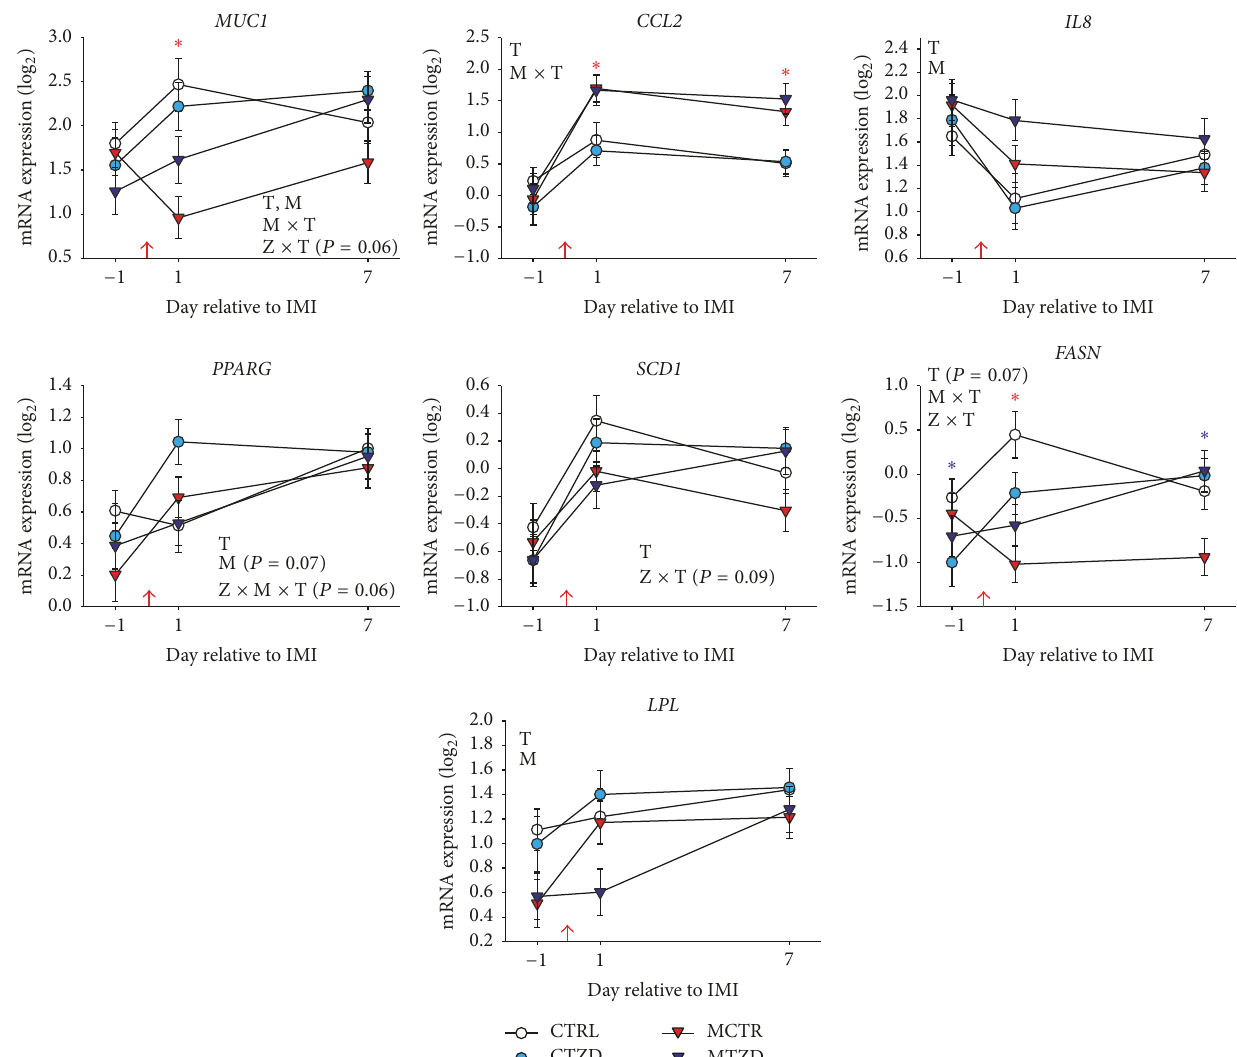
Figure 10: Transcript abundance of selected genes in mammary epithelial cells in goats receiving intramammary infusion (IMI) of Strep. uberis (M) or saline plus daily intrajugular injection of 2,4-thiazolidinedione (TZD) or saline (CTR). Significant ( 𝑃 ≤ 0.05 ) effects and interactions are indicated in the graph (mastitis: M, time: T, and TZD: Z). Significant differences due to mastitis × time (M × T) and TZD × time (Z × T) are denoted with red asterisk and purple asterisk,